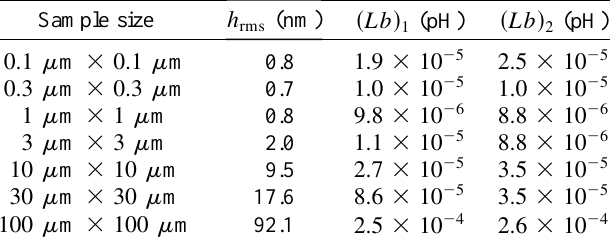
TABLE I. Product Lb for different samples.